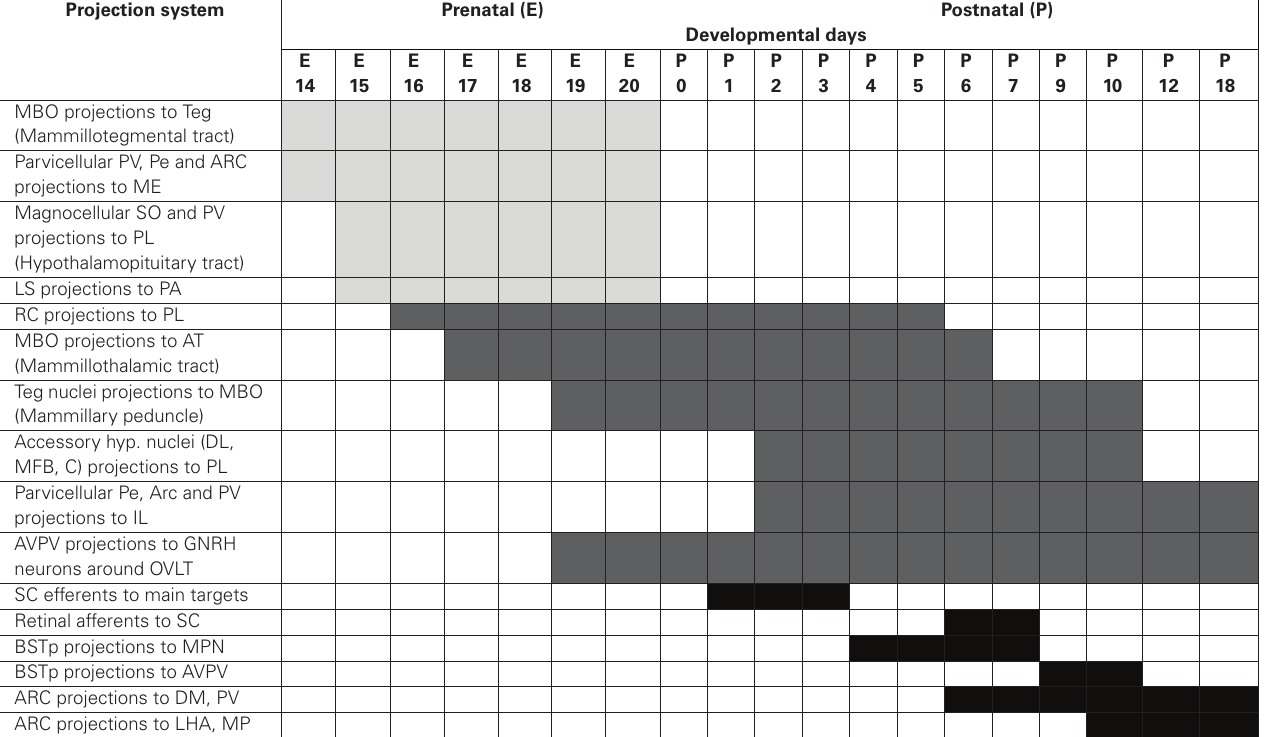
Table 1 | The time schedule of the development of hypothalamic projection systems studied using DiI tracing . Projection system Prenatal